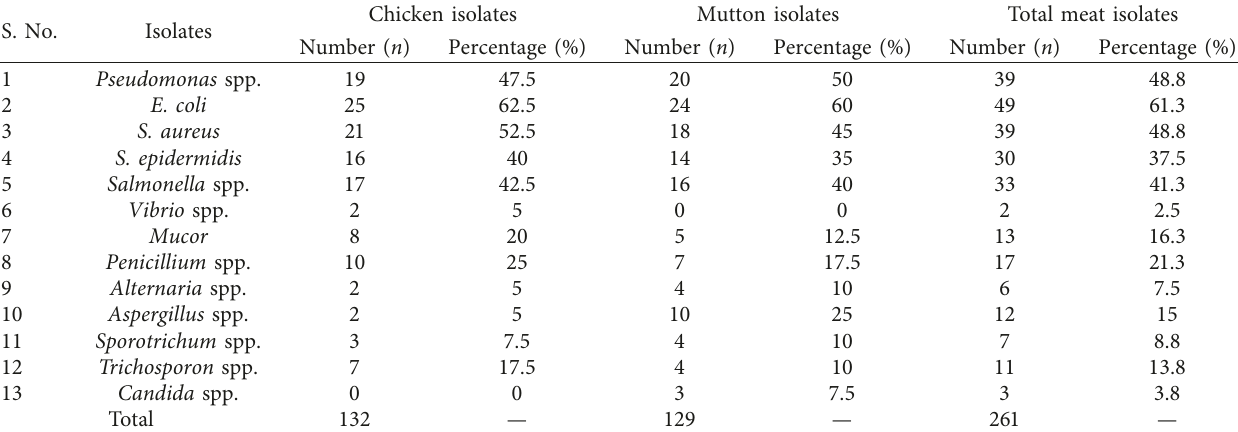
Table 1: Type of microbes isolated from chicken, mutton, and meat.